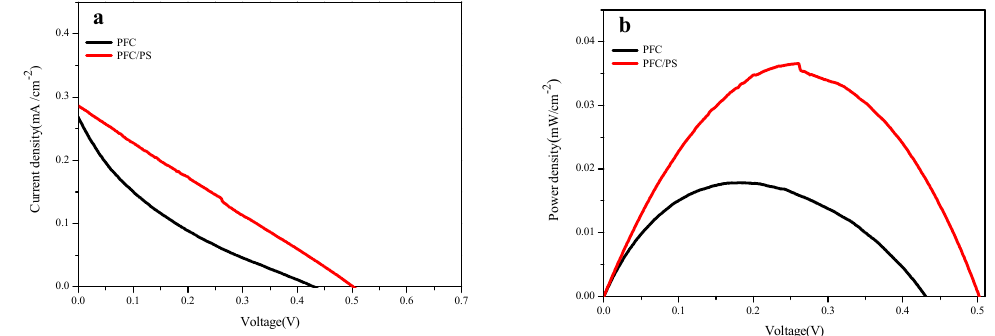
Figure 4. The current-voltage (I-V) characteristic curves ( a ) and the corresponding power density curves ( b ) of the PFC and PFC/PS systems. Experimental conditions: pH = 3.0, [NOR] = 10 mg/L, [PS] = 3 mM, and electrolyte: 0.1 M Na 2 SO 4 .